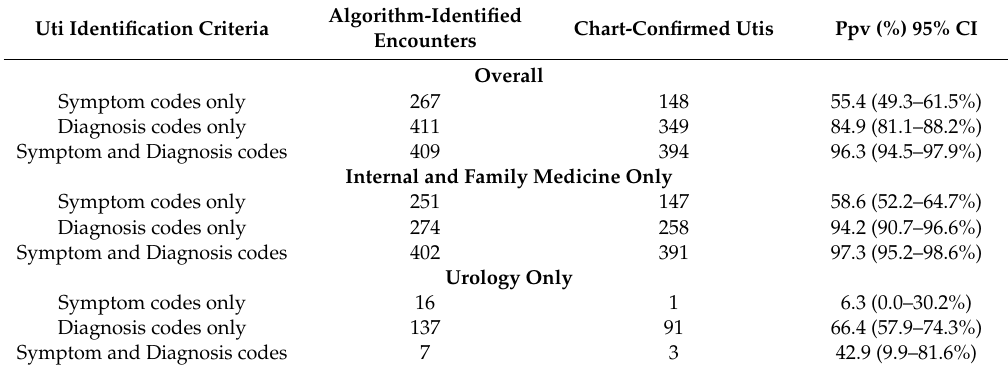
Table 2. Positive predictive values of algorithm by clinical